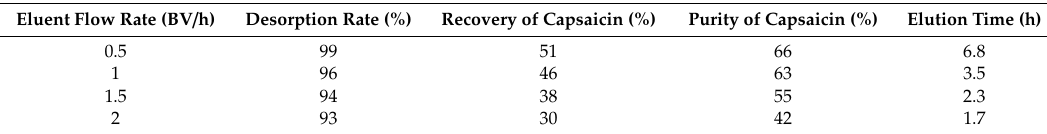
Table 7. E ff ect of the eluent flow rate using elution solvent of 45% ( v / v ) ethanol / 55% ( v / v ) aqueous sodium hydroxide (1%, w / w ).